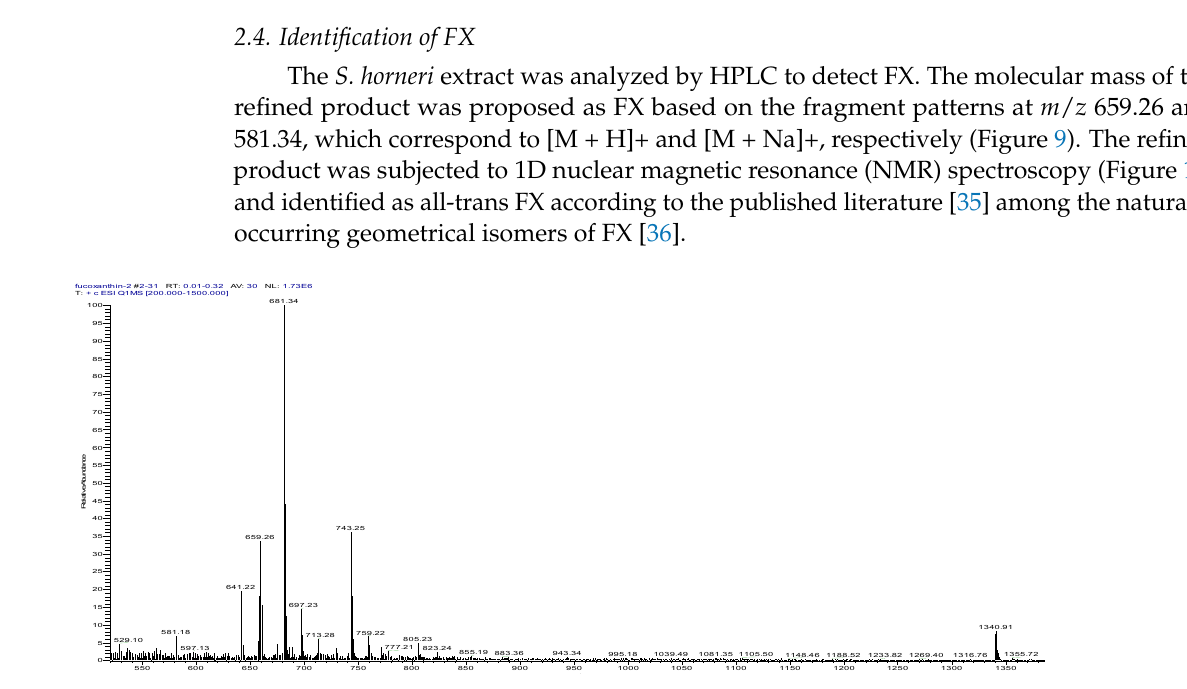
Figure 9. The positive ESIMS spectrum of FX obtained from the solution A4.